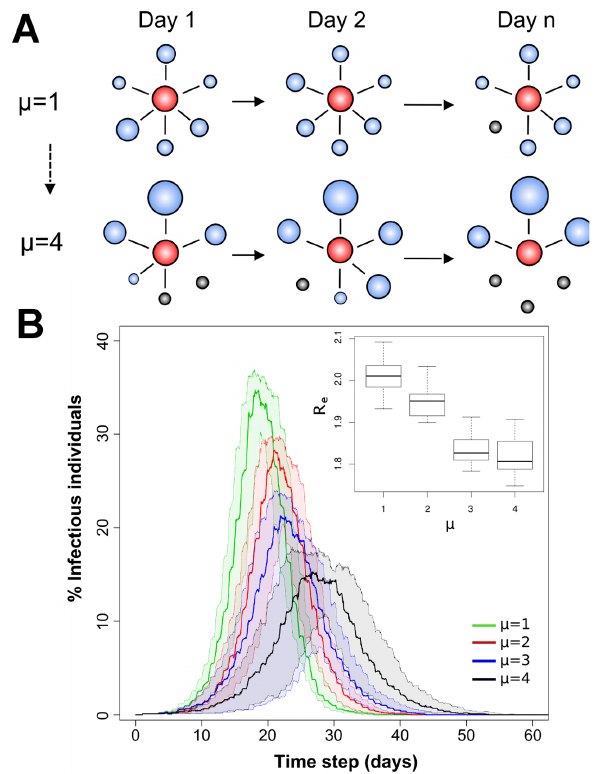
Figure 5. Impact of variable mobility routines on infectious disease dynamics. (A) Diagram outlining the parameter m from the individual-based model. Red bubbles indicate individuals whereas grey bubbles the locations that belong to their mobility routine. The larger the size of a bubble the more time an individual spent on a location. Some locations may not be visited every day. Individuals who visit and allocate their time into multiple locations have an unstructured routine ( m =1) whereas individuals who every day spend a significant proportion of their time at one or very few locations have structured routines ( m =4). (B) Epidemic curve and mean reproductive number ( R e ) for various scenarios simulating the transmission of an influenza-like pathogen within an Iquitos neighborhood. Models accounted for different levels of structure on an individual’s daily routine (from m = 1 to m = 4). Confidence bounds were calculated from 50 simulations performed under each scenario.